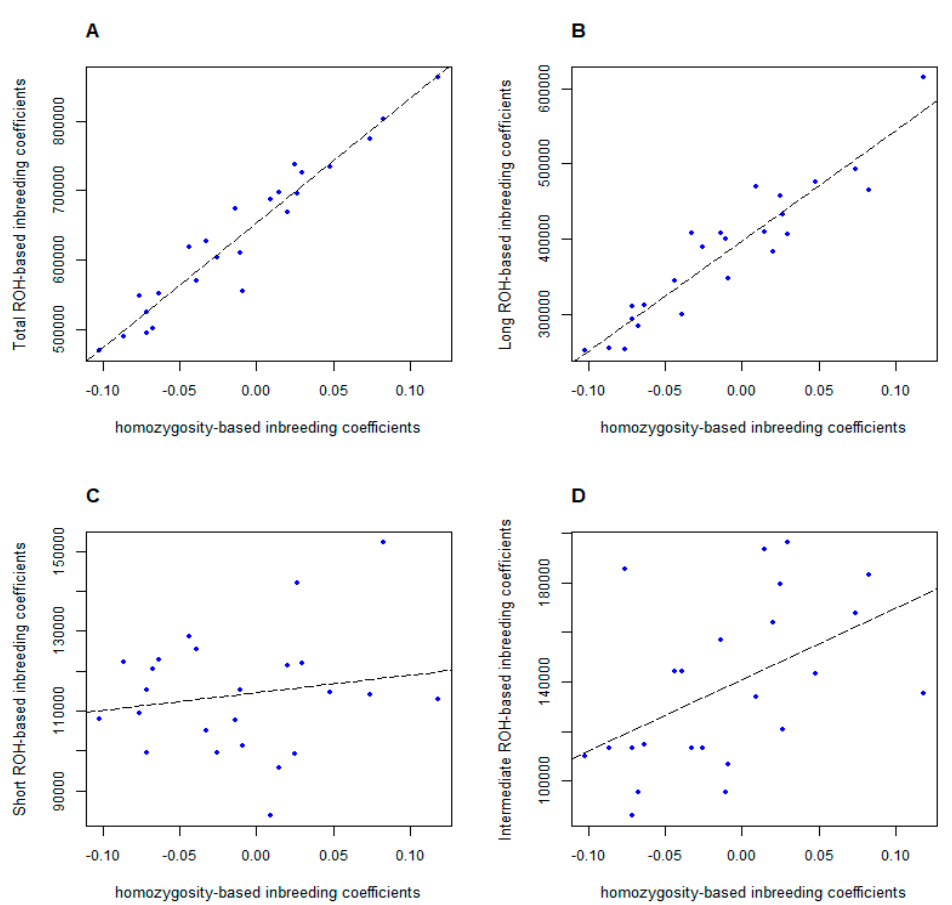
Figure 5. Relationship between ROH-based inbreeding coe ffi cients and homozygosity-based inbreeding coe ffi cients. ( A ) shows F HOM and F ROH (total) had a high correlation ( r = 0.949, p-value = 1.908e-06). ( B ) shows F ROH (long ROH) also was strongly correlated with F HOM ( r = 0.910, p-value = 2.614e-06). ( C ) shows F HOM and F ROH (short) had a low correlation ( r = 0.038, p-value = 0.860). ( D ) shows F HOM and F ROH (intermediate) had a low correlation ( r = 0.499, p-value = 0.014).